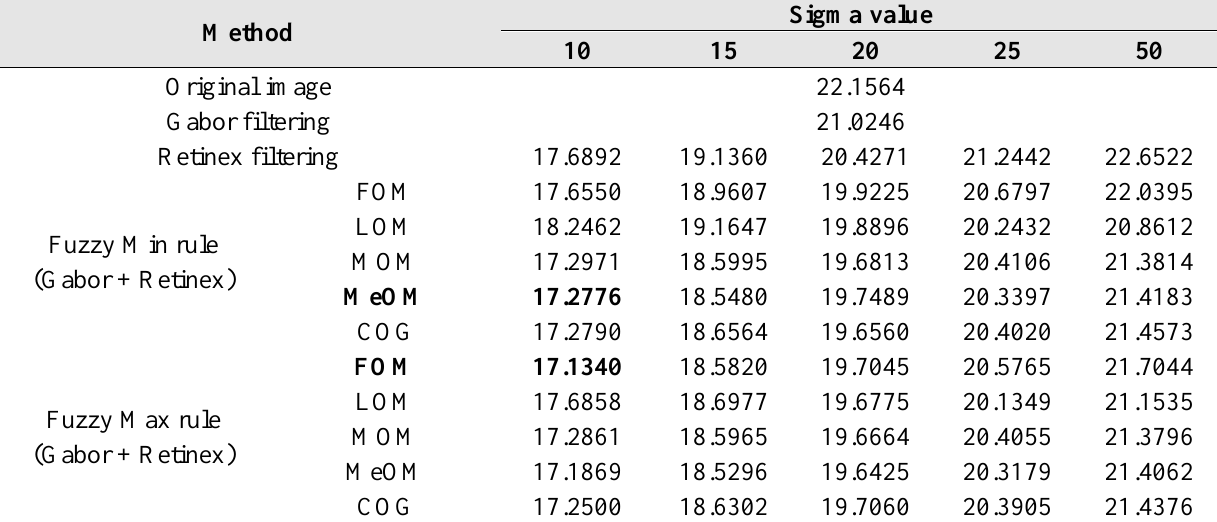
Table 5. Recognition accuracy of the proposed method with Gabor filtering and Retinex filtering, with various sigma values, and a Daubechies wavelet in terms of EER for images from database I (unit: